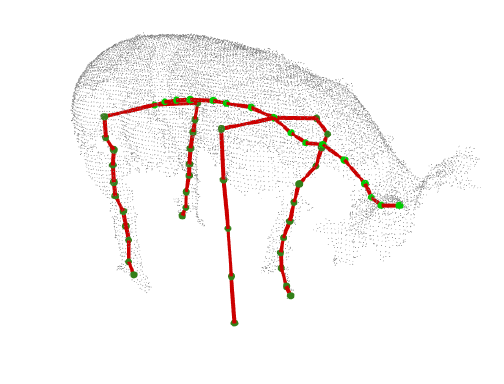
Figure 8. An extracted skeleton with an added model